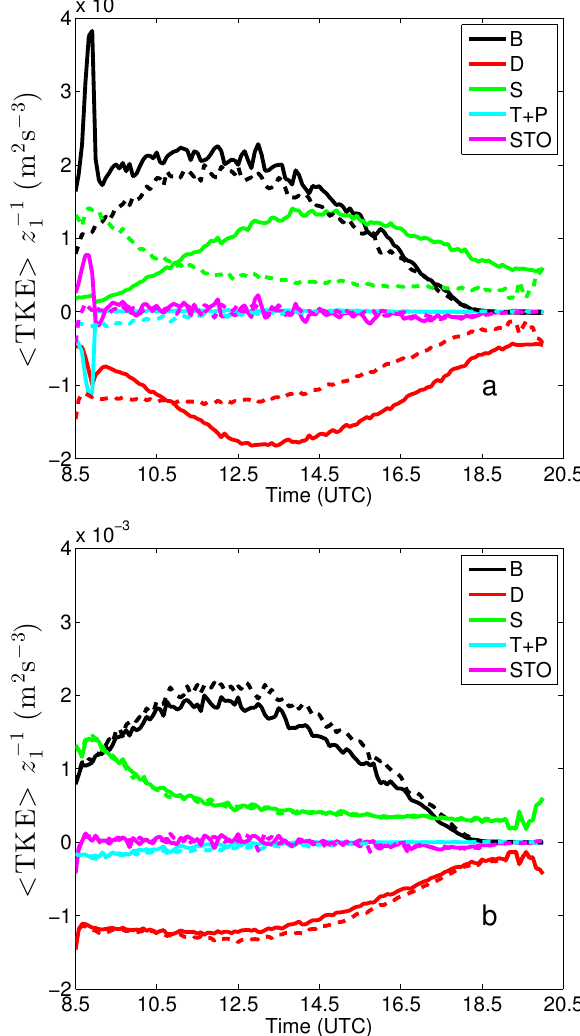
Fig. 8. Temporal evolution of each vertically averaged (from 0 to z 1 ) TKE–term normalized by z 1 . In (a) the influence of the RL is shown for (solid) RLns and (dashed) nRLns numerical experiments. In (b) the influence of subsidence for (solid) nRLns and (dashed) nRLs numerical experiments can be analyzed.